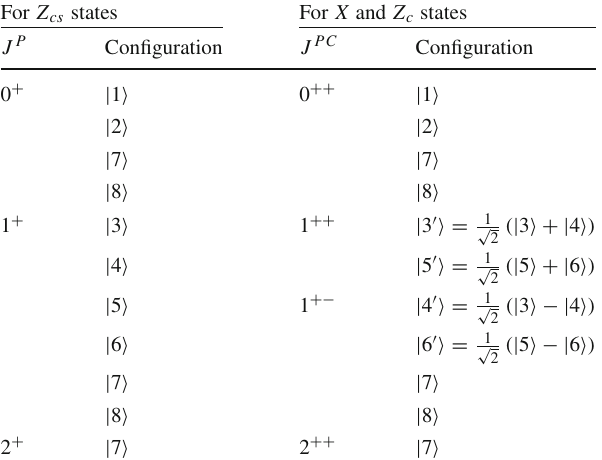
Table 3 The symmetry configurations of hidden-charm systems For Z cs states For X and Z c states J P Configuration J PC Configuration